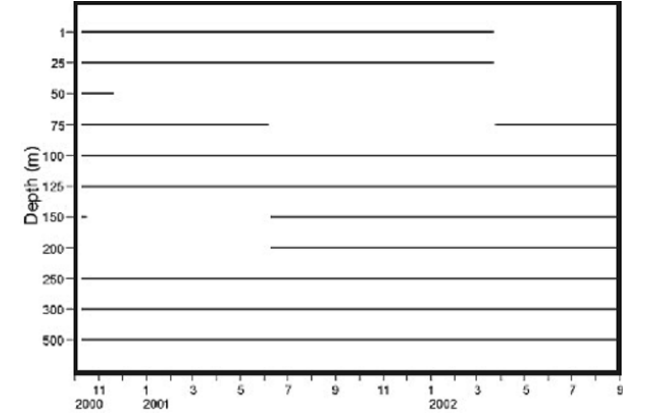
Fig. 2. Durations of recorded temperature measurements on the mooring at the SEATS station.